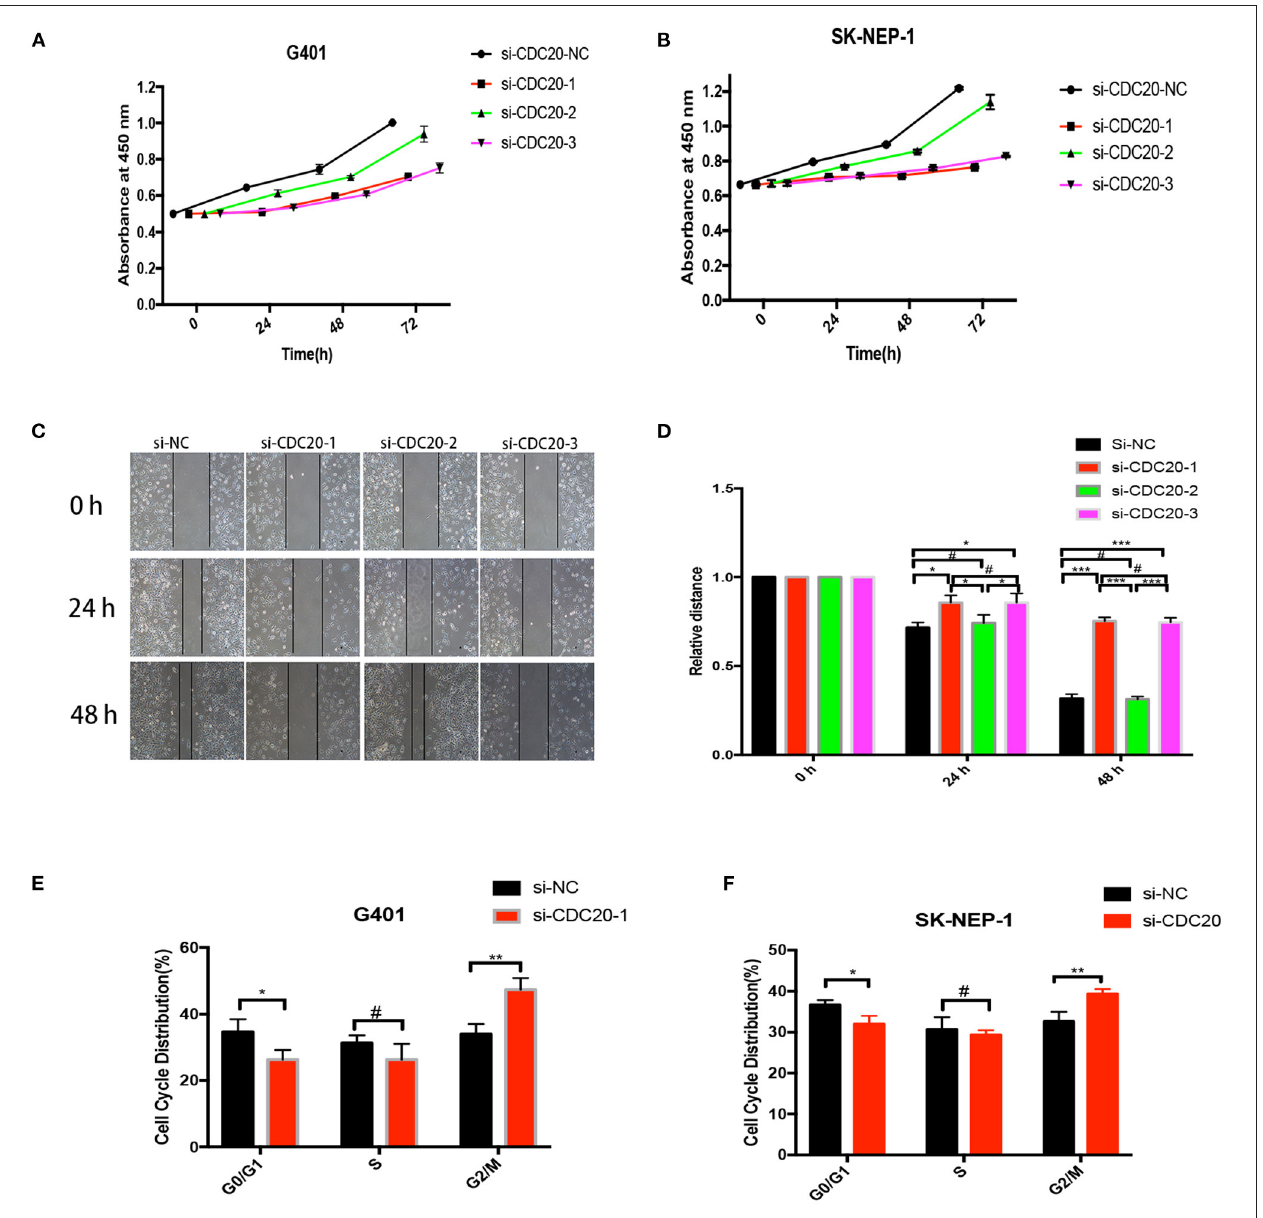
FIGURE 4 | CDC20 controls cell proliferation, migration, and cell cycle in vitro . CDC20 siRNA suppression of proliferation of G401 and SK-NEP-1, respectively, in vitro (A,B) . Wound healing assays were performed to determine the migration rate of G401 cells at 24 and 48h after transfection of siRNA (C,D) . The G0/G1, S, and G2/M phase proportions of G401 and SK-NEP-1 cells transfected with siCDC20 or NC (E,F) . Results are shown as the mean ± SD. For comparisons, the Student t -test was performed. * p < 0.05, ** p < 0.01, *** p < 0.001, # p >